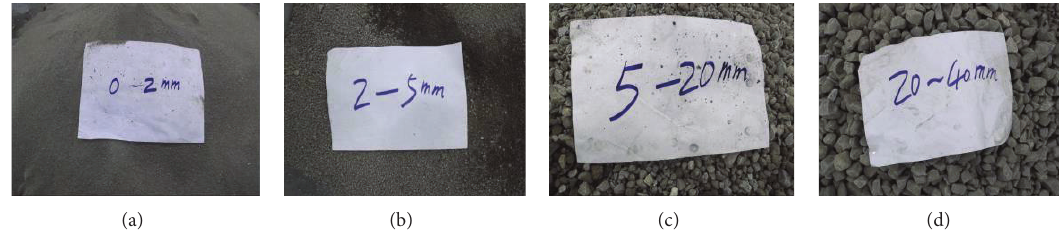
Figure 3: Rock and soil particles used for the experiments, (a) 0–2mm, (b) 2–5 mm, (c) 5–20 mm, and (d) 20–40 mm.